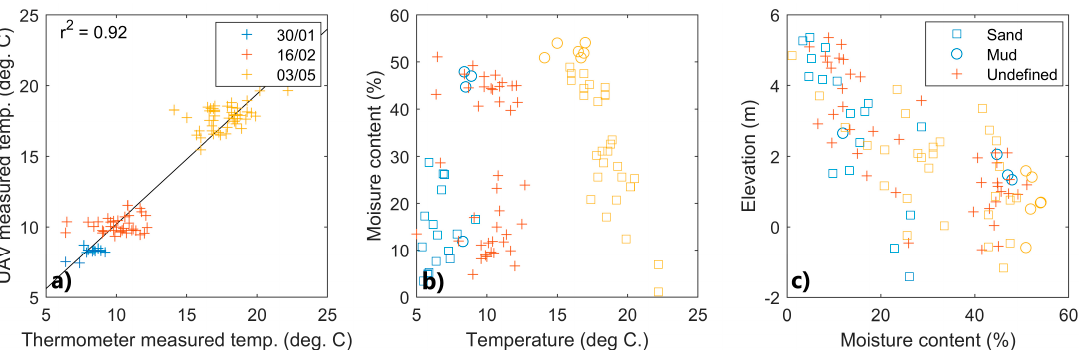
Figure 5. A plot of UAS measured temperature against point measured temperature, with the line of best fit indicated ( a ); point-measured moisture content against point measured temperature ( b ); and point-measured moisture content against point-measured elevation ( c ). Data is from the three flights at the Neath site with color indicating flight data and shape of symbol indicating sediment type as shown on the legend.